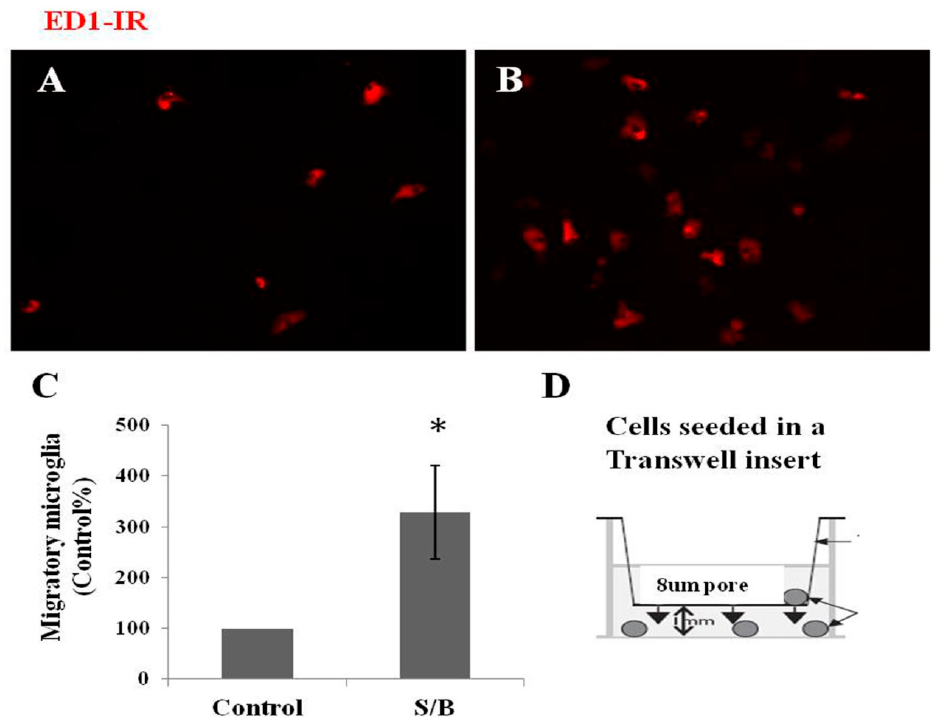
Figure 4. Effect of S/B remedy on microglial migration in mixed glial cultures , wherein ( A ) shows control cultures, ED1 ‐ IR microglia, ( B ) shows S/B ‐ treated cultures, ED1 ‐ IR microglia, ( C ) shows quantitative results of migratory microglia, and ( D ) refer to a cell ‐ seeded Transwell insert scheme. Mixed glial cells were seeded on 8 μ m hanging Transwell inserts inside 24 ‐ well plate and maintained in growth medium in the presence or absence of S/B (10 μ g/mL) treatment for two days. The migratory microglia in the bottom wells were immunostained and counted. Data are expressed as means ±SEM from three independent experiments. The symbol “*” indicate statistical significance by one ‐ way ANOVA and Bonferroni t ‐ test at P < 0.05 (S/B vs. Control group).